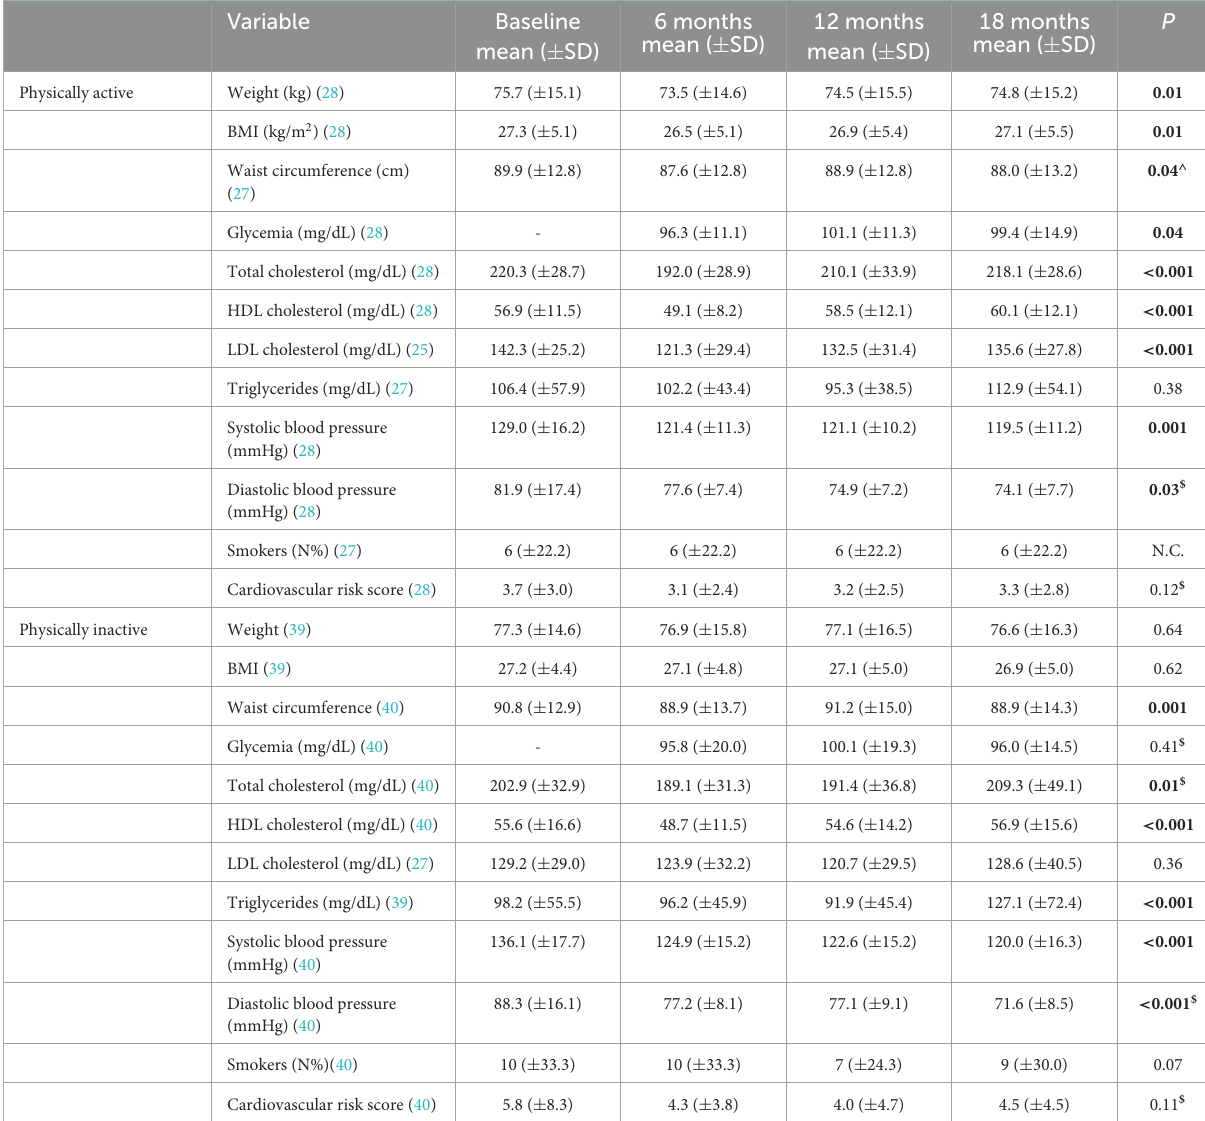
TABLE 4 Results of repeated measures ANOVA, stratified according to the physical activity